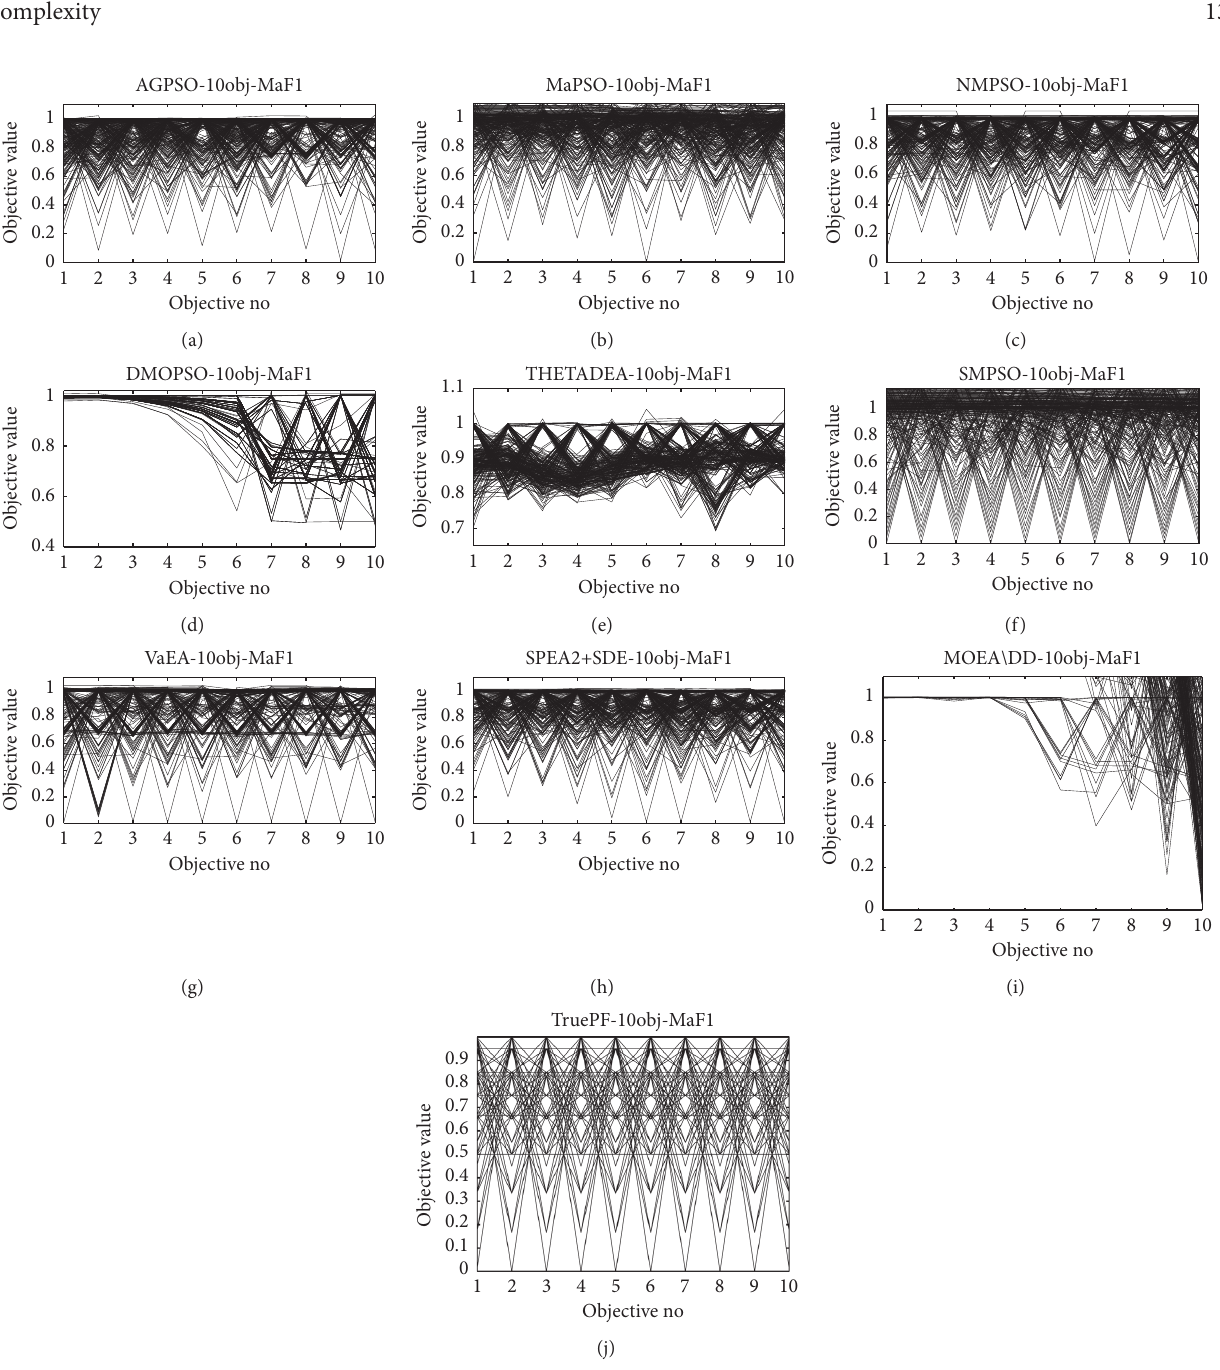
Figure 2: The final solution sets achieved by nine MOEAs/MOPSOs and the true PF on MaF1